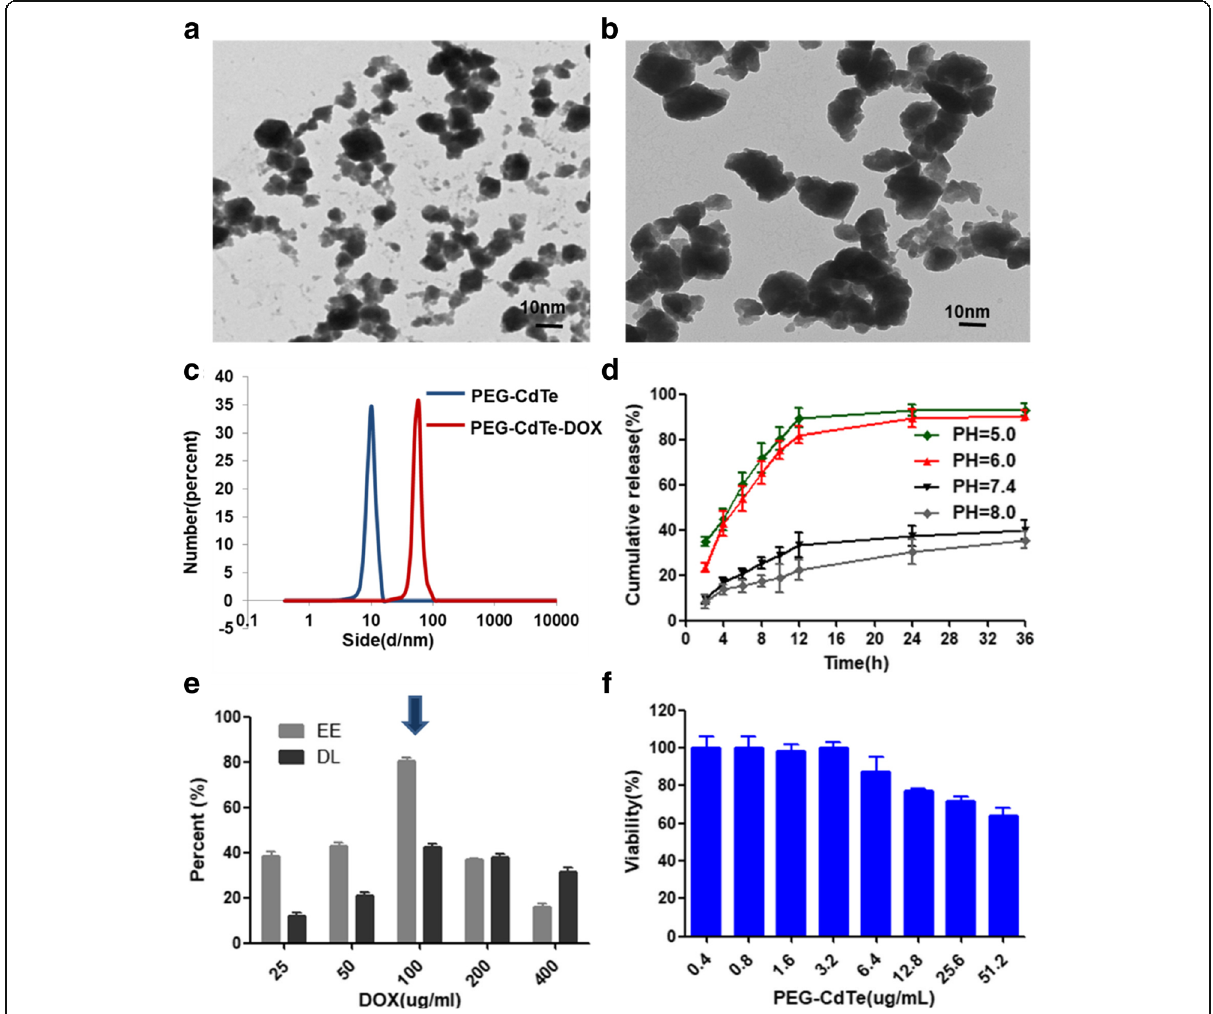
Fig. 2 Characteristics of PEG-CdTe and PEG-CdTe-DOX. Notes: a , b TEM images of PEG-CdTe and PEG-CdTe-DOX. c DLS analysis of PEG-CdTe and PEG-CdTe- DOX. e The optimized PEG-CdTe-DOX drug delivery system synthesizing from different incubation concentrations of DOX to PEG-CdTe. d DOX released from PEG-CdTe-DOX in PBS at pH 5.0, 6.0, 7.4, or 8.0 at 37 °C in vitro. f The viability of 293 t cells after treatment with different concentrations of